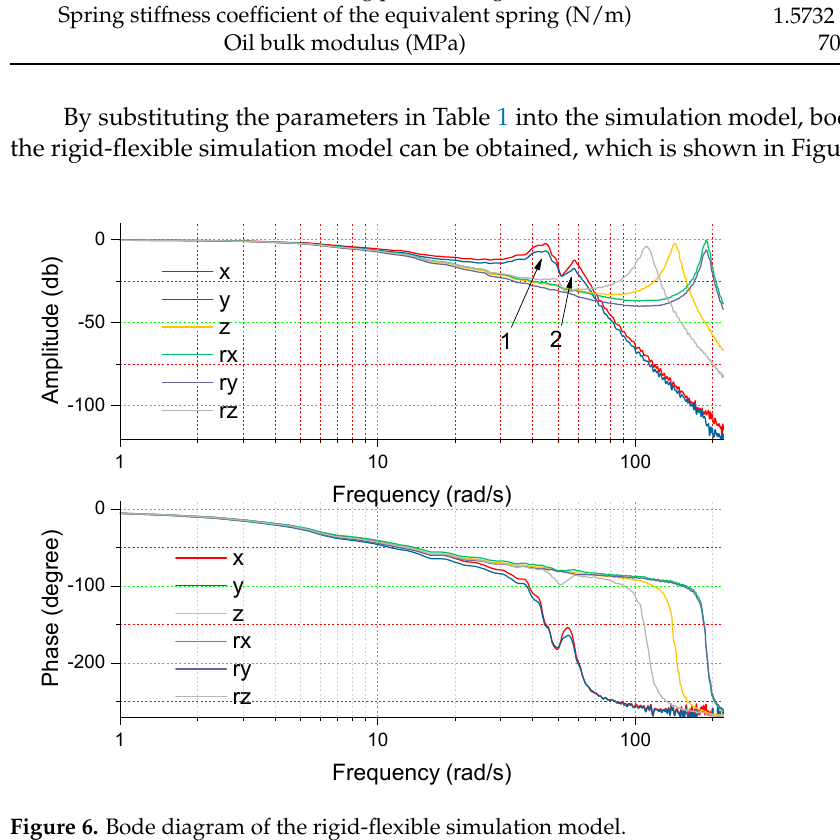
are shown in Table 1. Table 1. Configuration parameters and dynamic parameters of the simulation model.